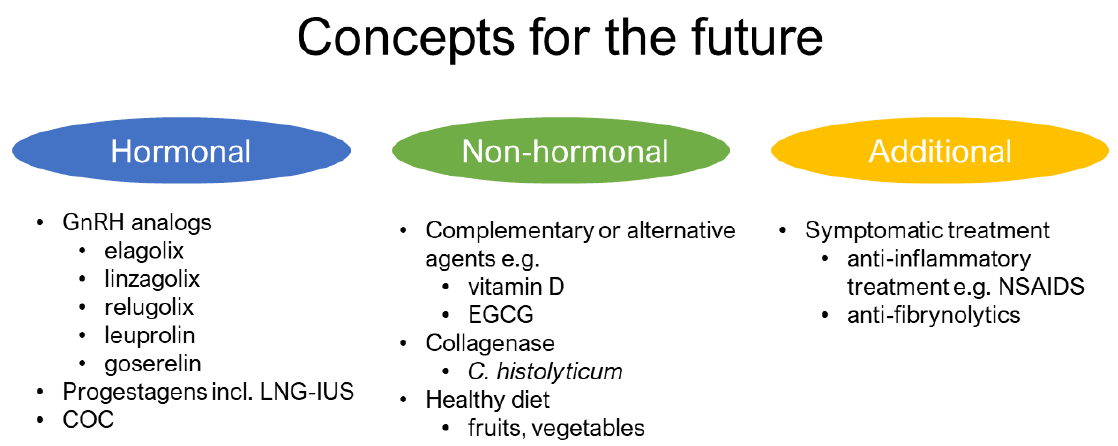
Figure 4. Current concepts on the use of natural anti-UF compounds. combined oral contraception—COC; epigallocatechin gallate—EGCG; gonadotropin-releasing hormone—GnRH; levonorgestrel-releasing intrauterine system—LNG-IUS; nonsteroidal anti-inflammatory drugs—NSAIDS.